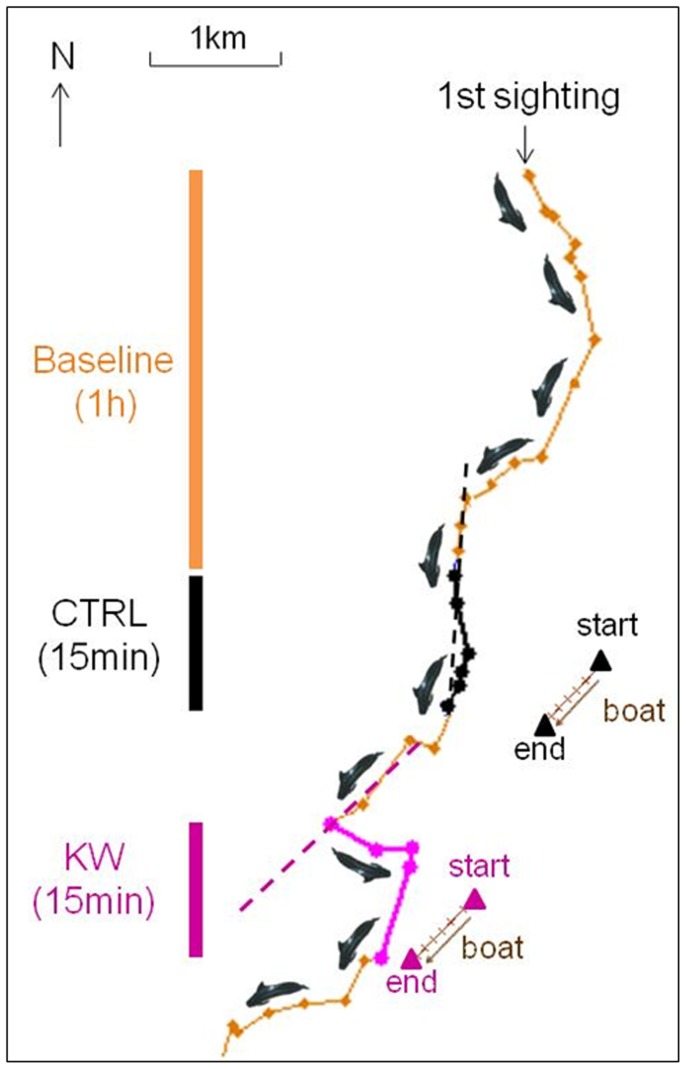
Track of tagged whale gm10_158d.Each dot corresponds to 1 sighting. Orange: baseline period. Black: control playback (CTRL) period. Magenta: killer whale playback (KW) period. Triangles: position of the sound source, at start and end of playbacks. Dotted lines: projected course of the whale as if the animal had kept its initial direction of horizontal movement.